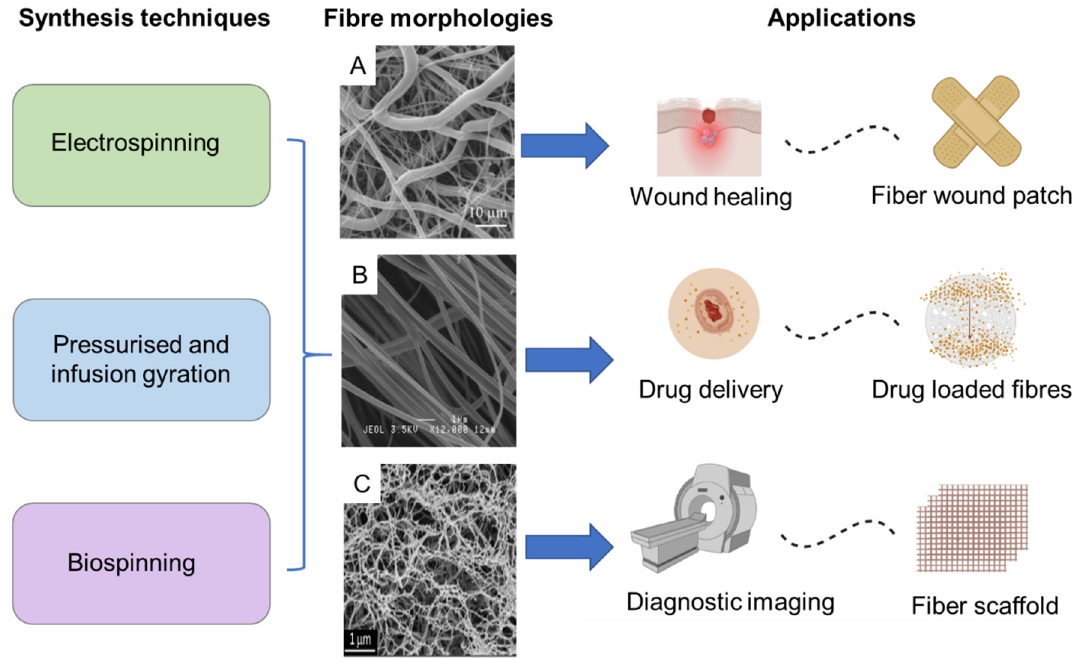
Figure 7. Diversity and versatility of MNP incorporated fibre based magnetic nanosystems in terms of synthesis, fibre morphology and scope of applications. Reproduced with permission from: ( A